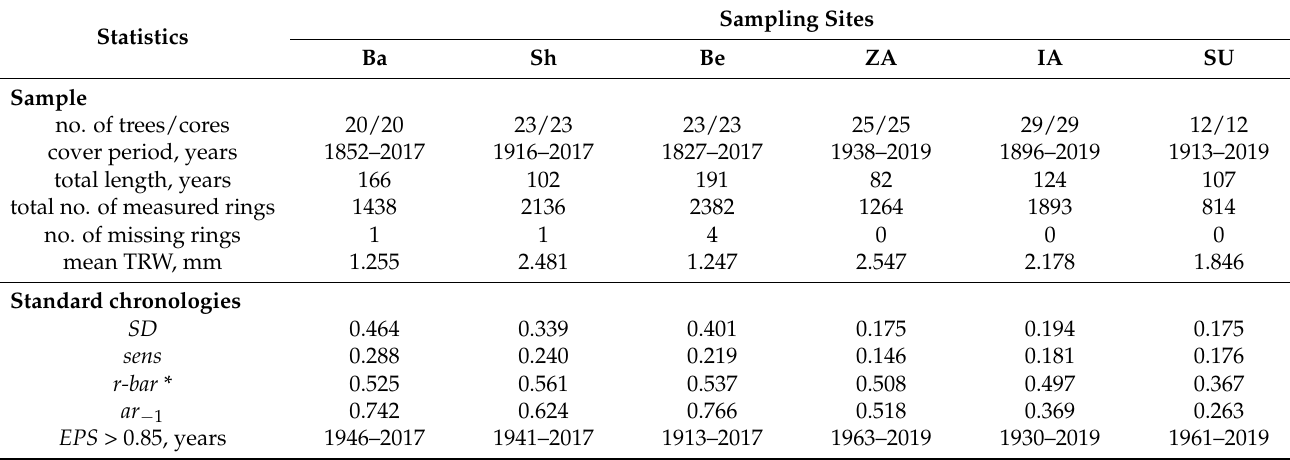
Table 2. Statistics of local tree-ring width chronologies. Sampling sites: Ba—Bayanaul, Sh—Shalday,